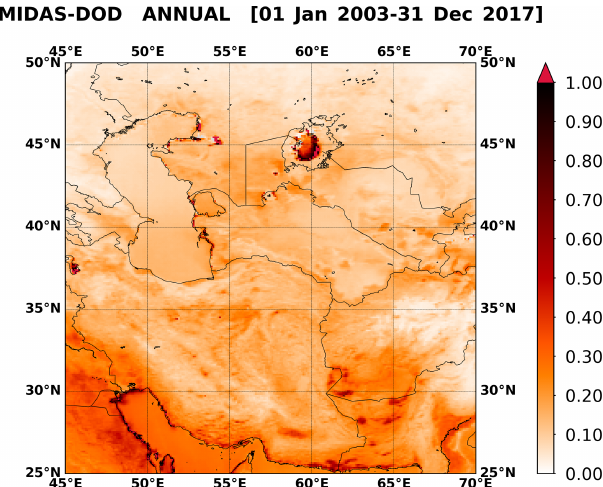
Figure 3. As in Fig. 1 but for central and southwestern